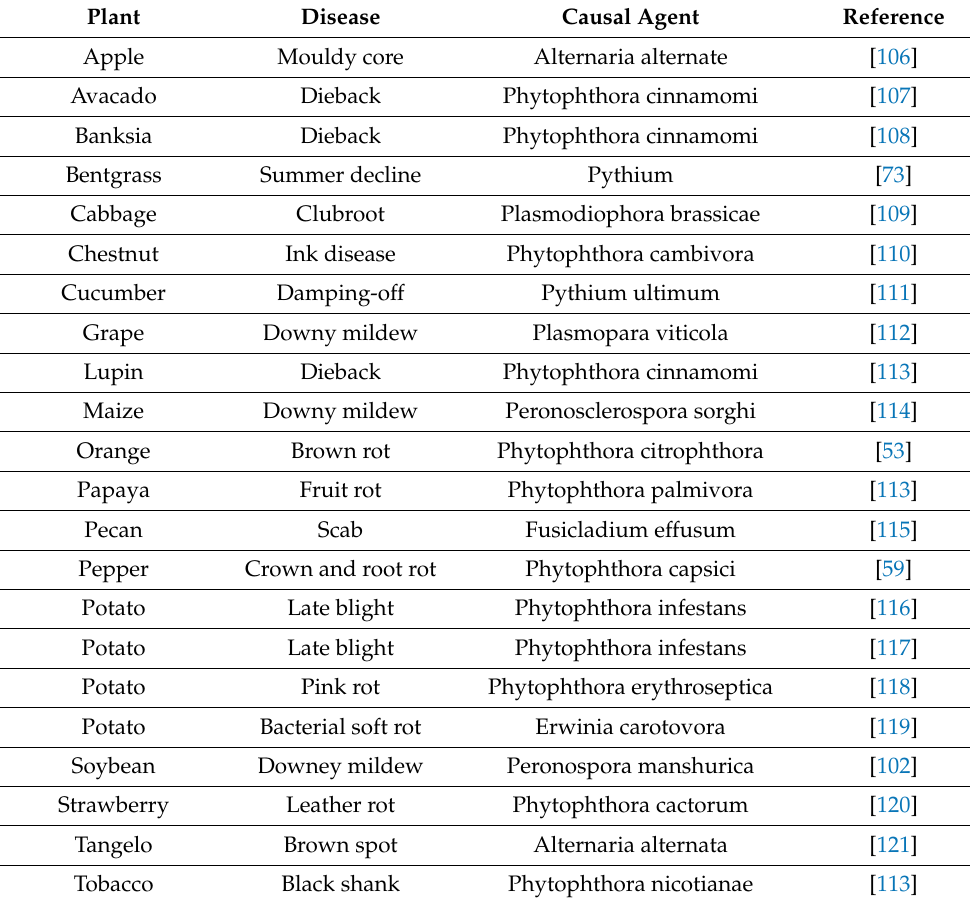
Table 3. Summary of reported Phi control of fungal diseases in crops. Adapted from